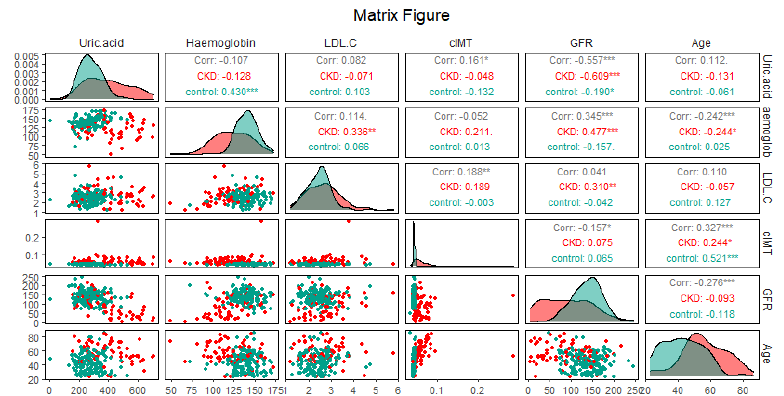
Figure 3. Matrix scatter plot among uric acid, haemoglobin, low-density lipoprotein-cholesterol (LDL-C), carotid intima-media thickness (cIMT), glomerular filtration rate (GFR) and